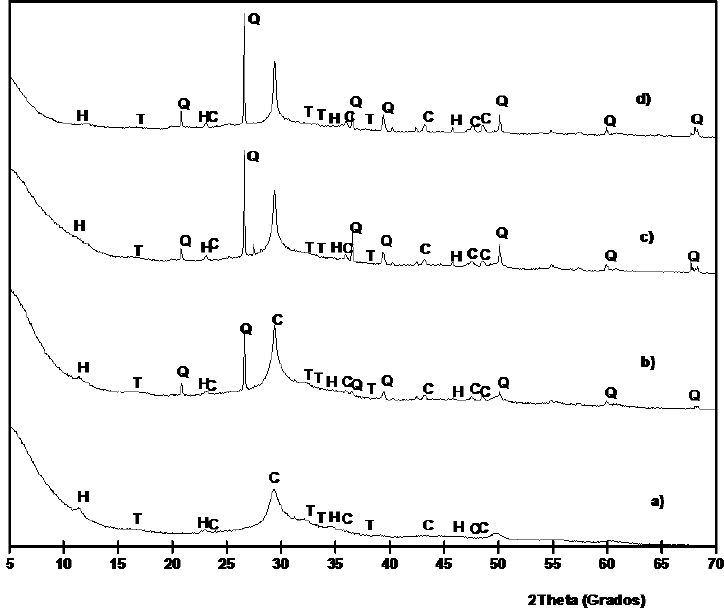
Figure 9. XRD diffractograms for BFS/SCBA pastes cured for 3 days at 65 °C: ( a ) 100/0; ( b ) 85/15; ( c ) 75/15; ( d ) 60/40. (Key: Q: Quartz; C: Calcite; T: Thermonatrite; H: